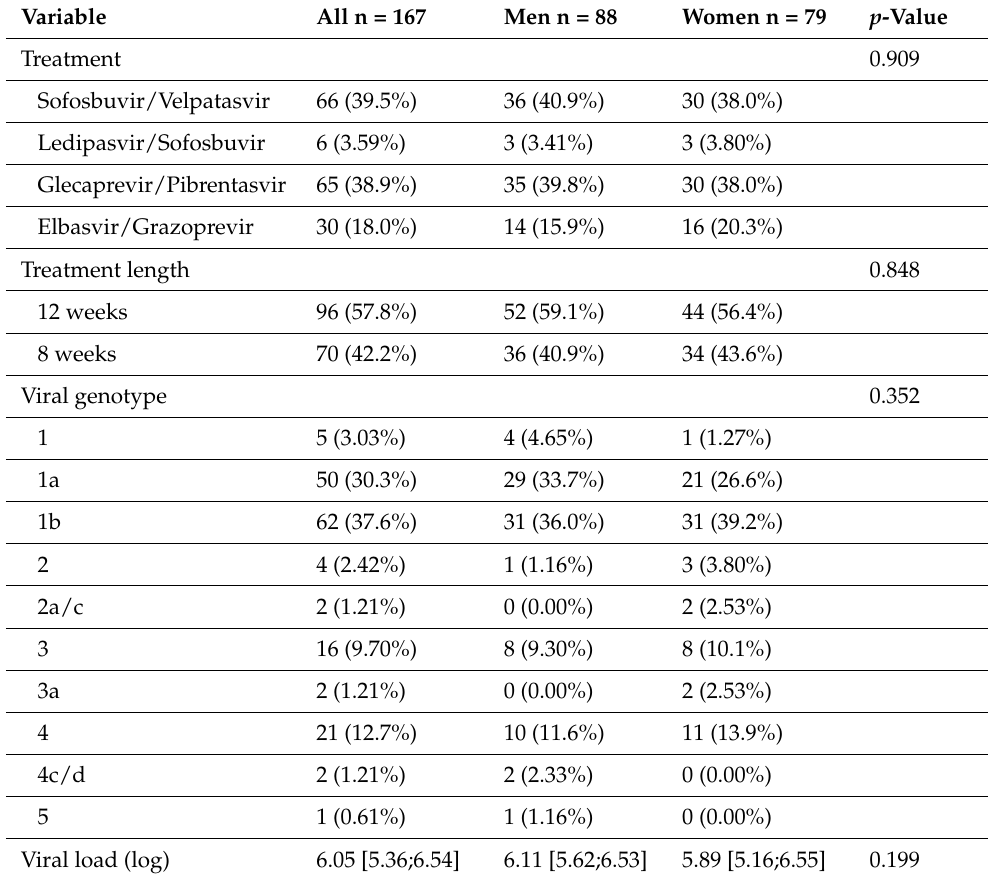
Table 2. HCV infection characteristics and treatment